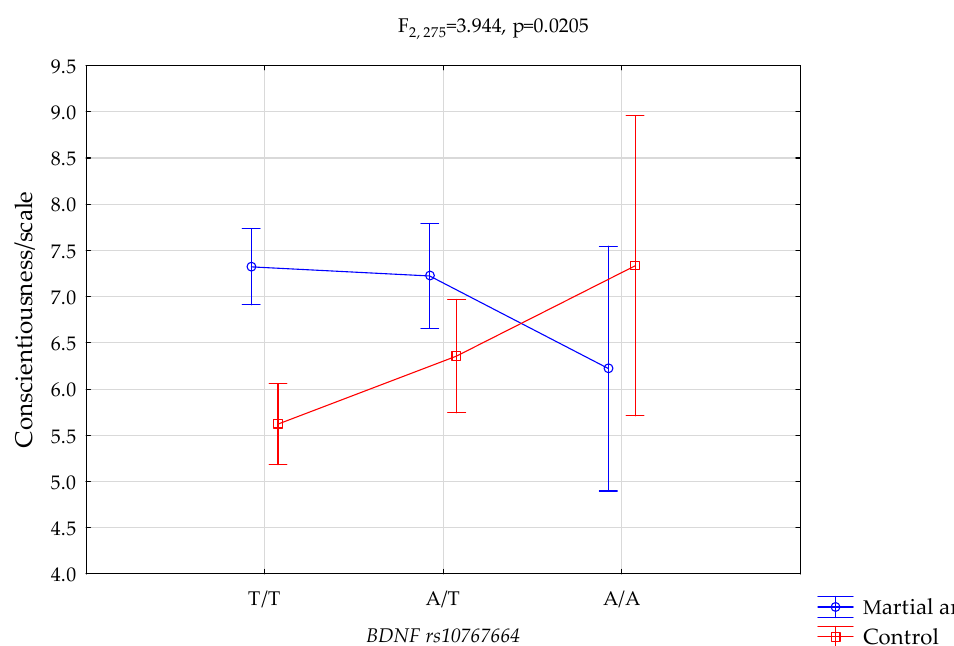
Figure 1. Interaction between s martial arts/control and BDNF rs10767664, and the conscientiousness scale.